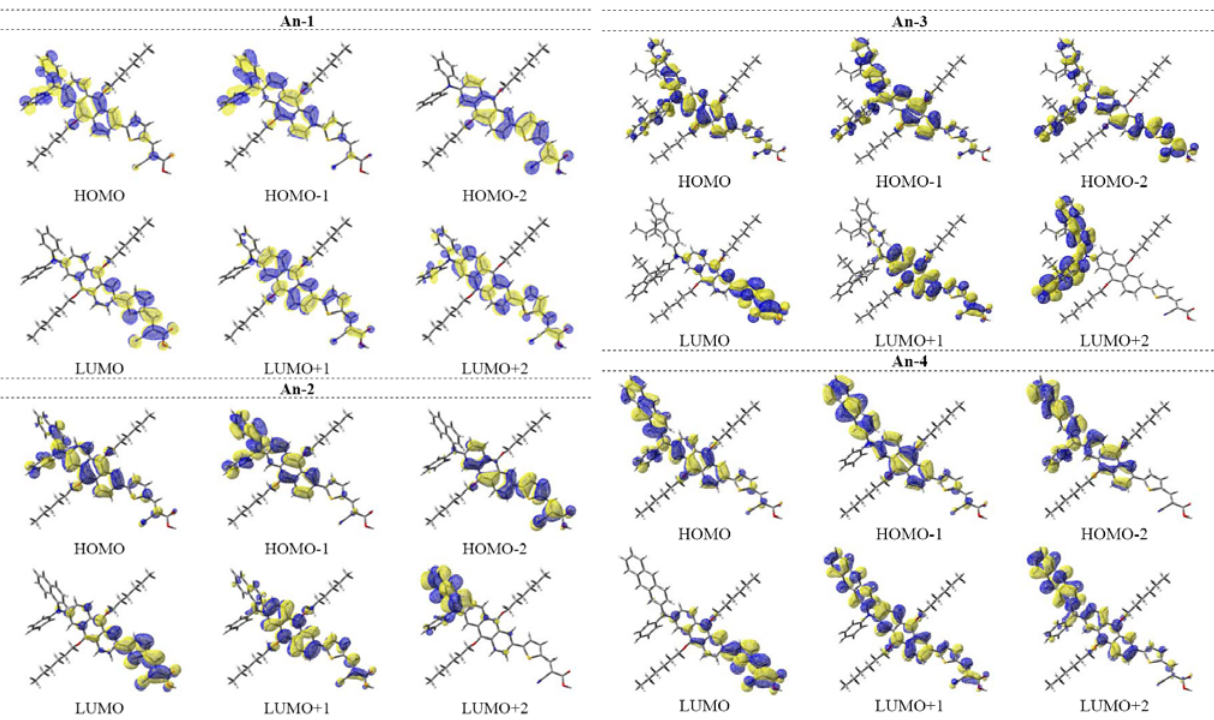
Figure 11. Selected frontier orbitals of the dyes.